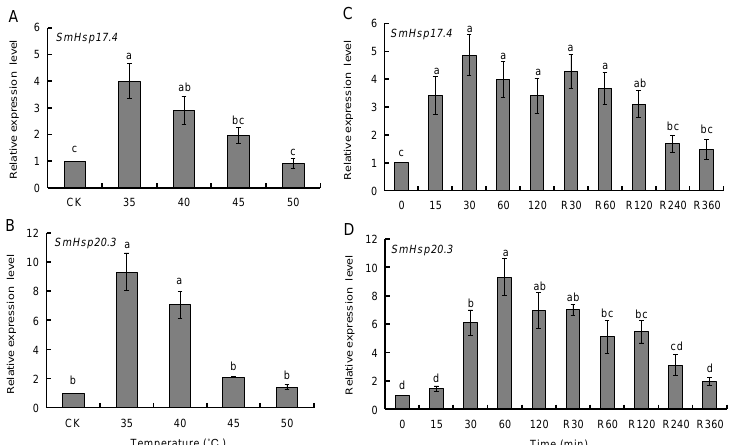
Figure 5. Effect of high temperature extremes on expression of SmHsp17.4 and SmHsp20.3 in over- summering diapausing larvae. ( A , B ) Exposure to various high temperature (35–50 °C) for 1 h. ( C , D ) Exposure to 35 °C for various time periods (0–120 min, left side), as well as a 60 min expo- sure to 35 °C followed by different recovery time (R30–360 min, right side). Expression level of each treatment was relative to that of the untreated control (CK, 0 min), which was arbitrarily set at 1. Bars represent the means ± SE. The different letters above the columns indicate significant difference by Duncan’s multiple range test ( p < 0.05).